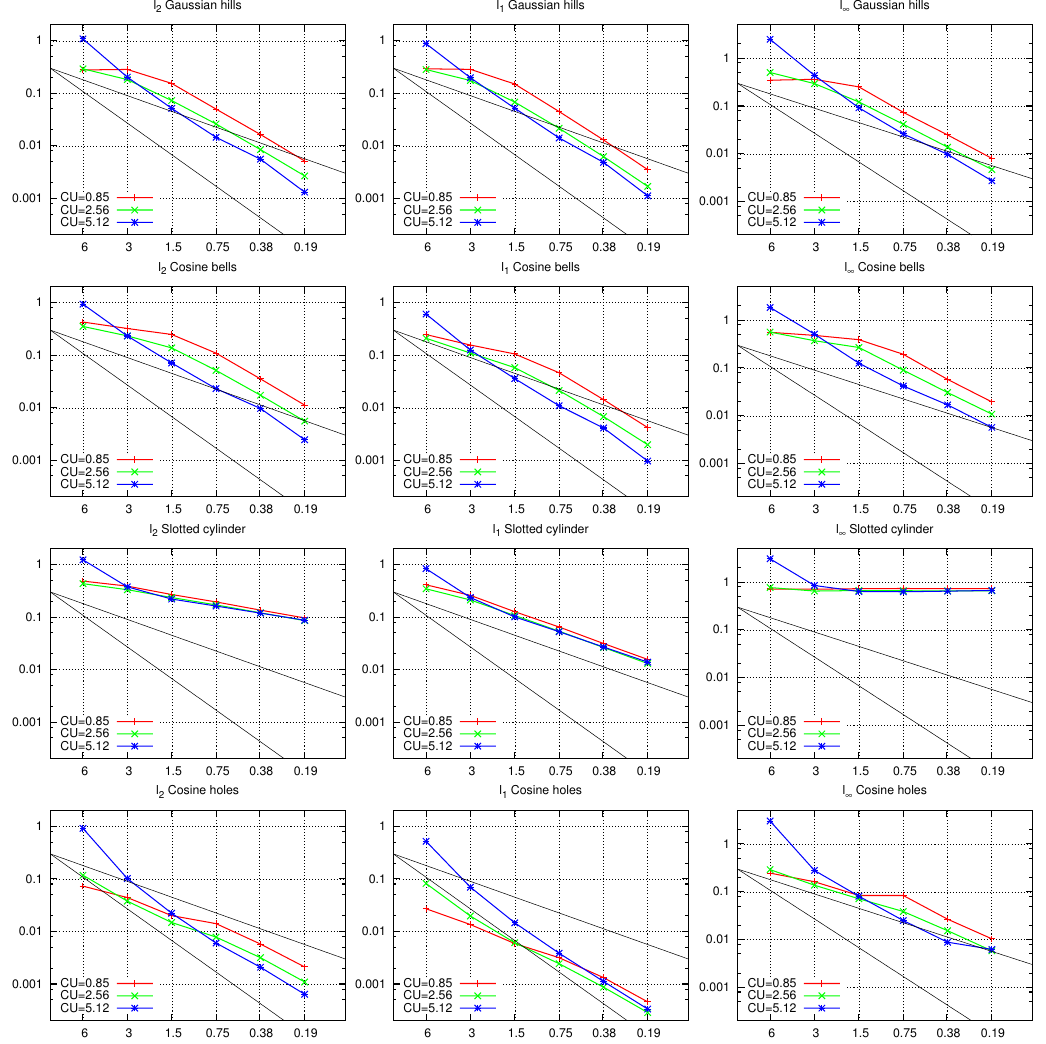
Figure 12. Dependence of the performance metrics l1, l2, and l ∞ for the spherical 2-D tests with initial shapes of Fig. 8. Dashed straight lines mark the slope for the first and second order of convergence. Without